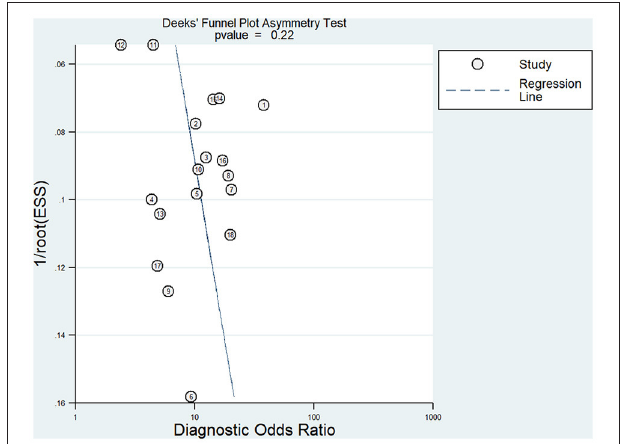
FIGURE 4 | Bivariate boxplot evaluating the heterogeneity.